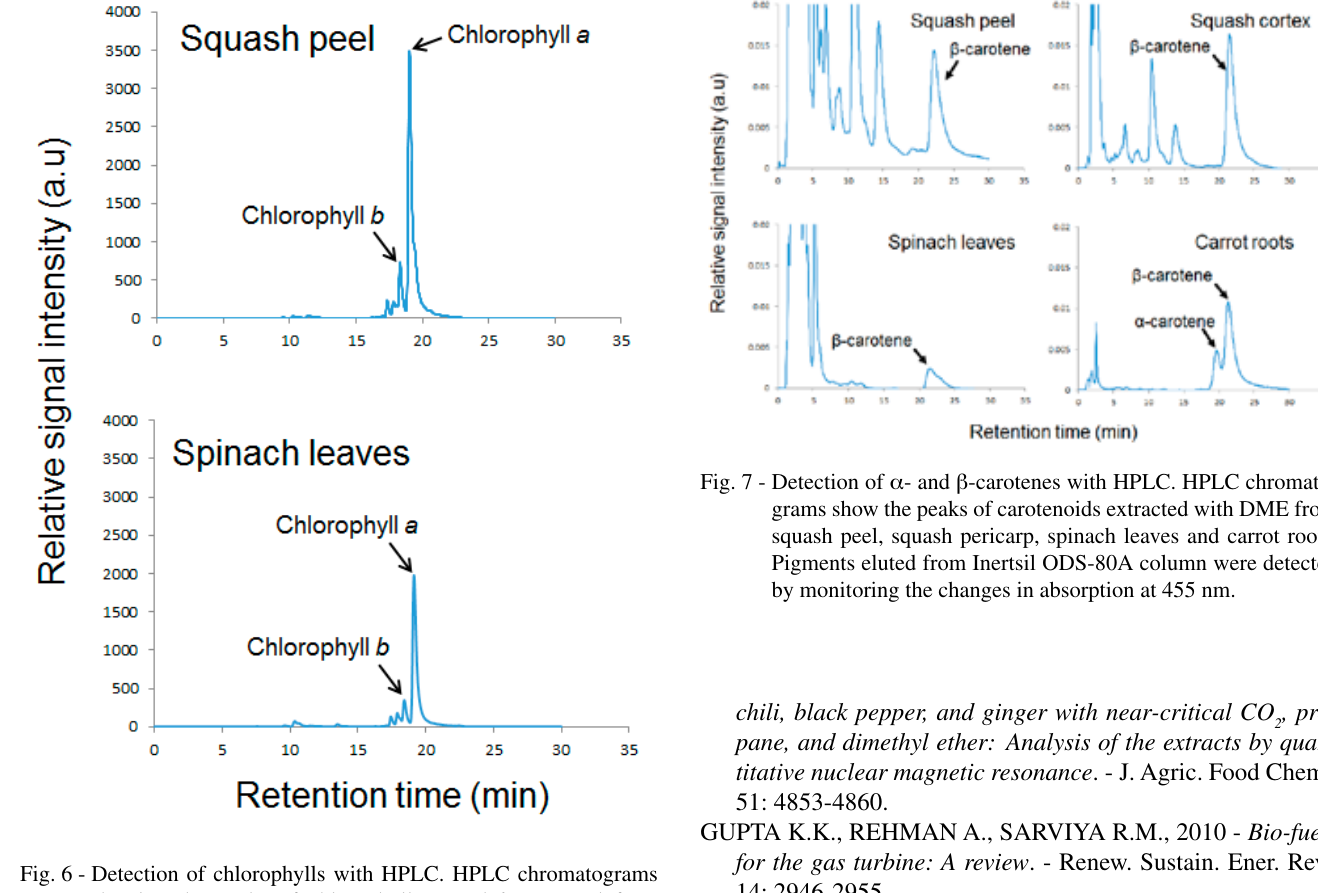
Fig. 6 - Detection of chlorophylls with HPLC. HPLC chromatograms showing the peaks of chlorophylls a and b extracted from squash peel and spinach leaves using DME. Pigments eluted from Inertsil ODS-80A column were detected by intrinsic fluo- rescence intensity (excitation, 405 nm; emission, 660